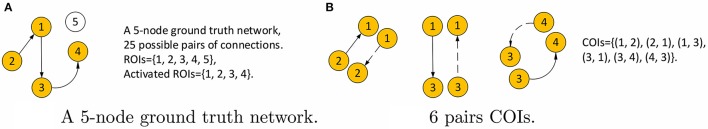
Example calculation of the threshold s for a 5-node network. (A) The network with activated ROIs shown in orange. The number of all possible connections is 52 = 25. (B) The 6 COIs, where the dashed lines are connections that do not existed in the ground truth but still are considered interesting. Therefore, s = 6/25 for this network.